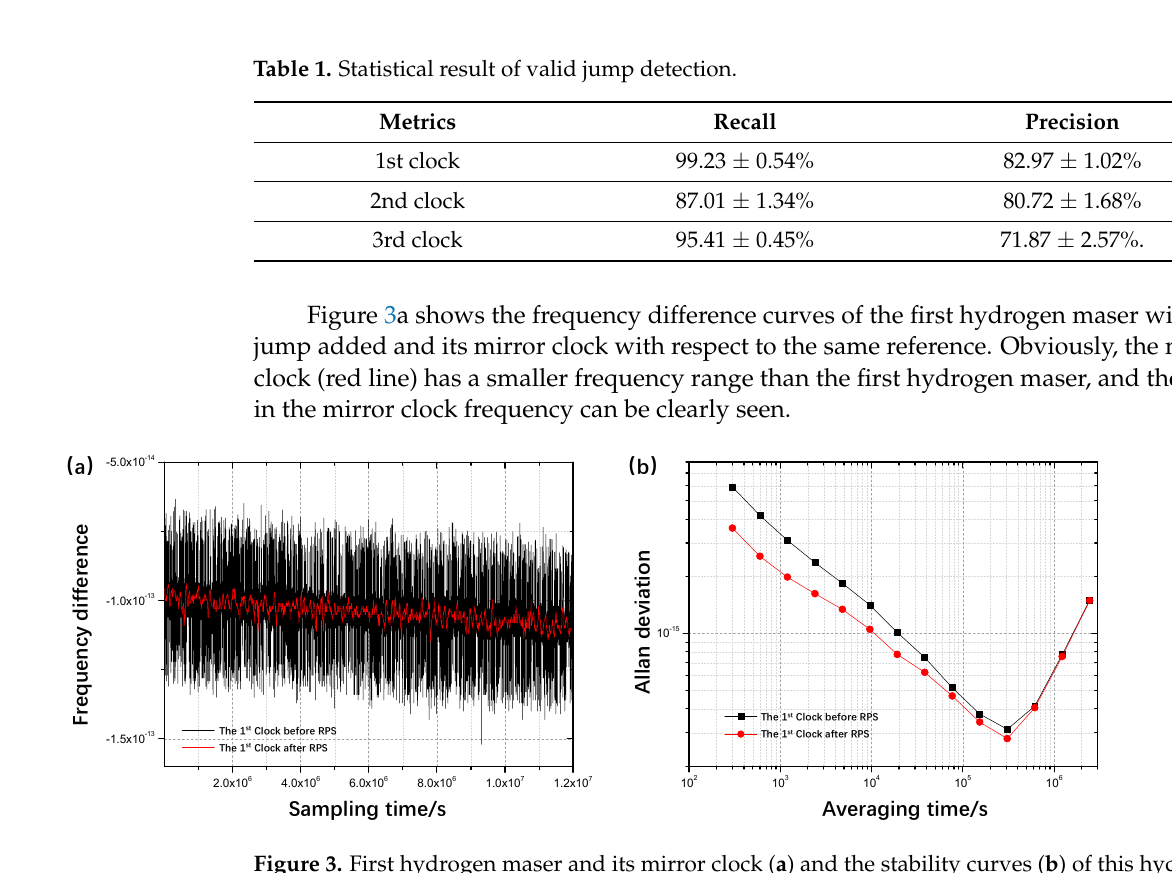
6 of 9 Table 1. Statistical result of valid jump detection.